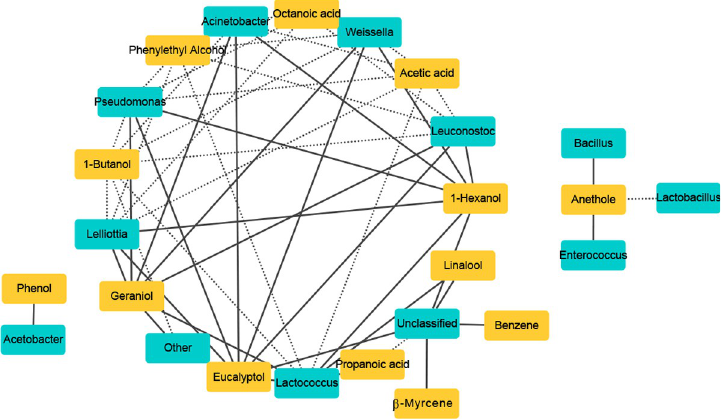
Fig 8. Spearman correlations between metabolites by GC-MS analysis and main bacteria species. Differentially expressed metabolites during fermentation were screened by PLS-DA; Positive correlations are indicated with solid lines (R > 0.90) and negative correlations are shown by dashed lines (R < -0.90).